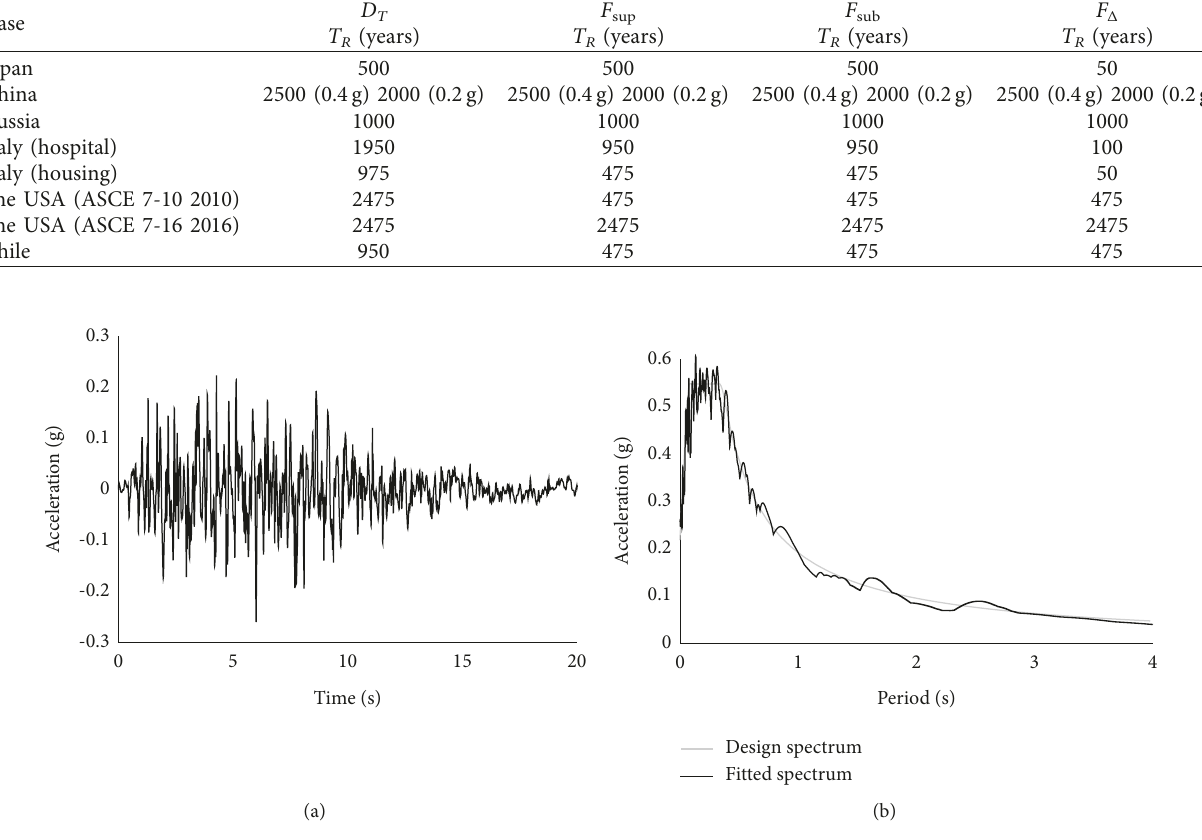
Figure 6: Example accelerogram selected to fit a design spectrum for the analysis of the hospital buildings. (a) Accelerogram. (b) Fit between both spectra.